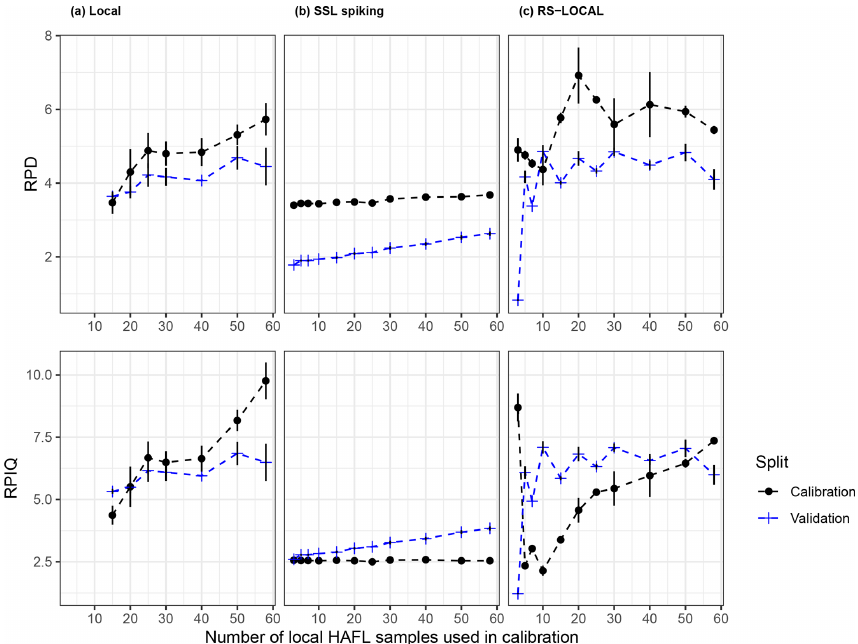
Figure 8. RPD and RPIQ vs. the number of local HAFL samples used in local HAFL (a) , local combined with SSL (b) and RS-LOCAL subsets, where k = 100 (c) . Error bars represent the SD between resampled repetitions, and where not present, there was no variation in the respective summary statistic across five repetitions. Dashed lines between data points do not represent real measurements and are only for visual